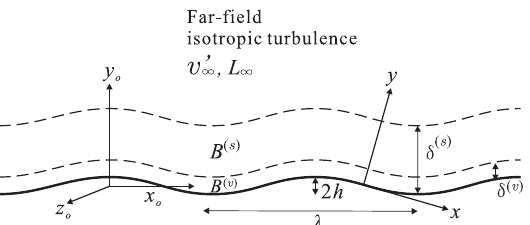
Fig. 1 Sketch of flow configuration. x 0 and y 0 are fixed coordinates and x and y are local coordinates aligned with the surface. B ( s ) and B ( v ) are the source and viscous layers, respectively. Assuming a high Reynolds number (i.e. δ ( v ) (cid:3) δ ( s ) ), viscous e ff ects are not considered in this study, where δ ( s ) and δ ( v ) are the thickness of source and viscous layers,